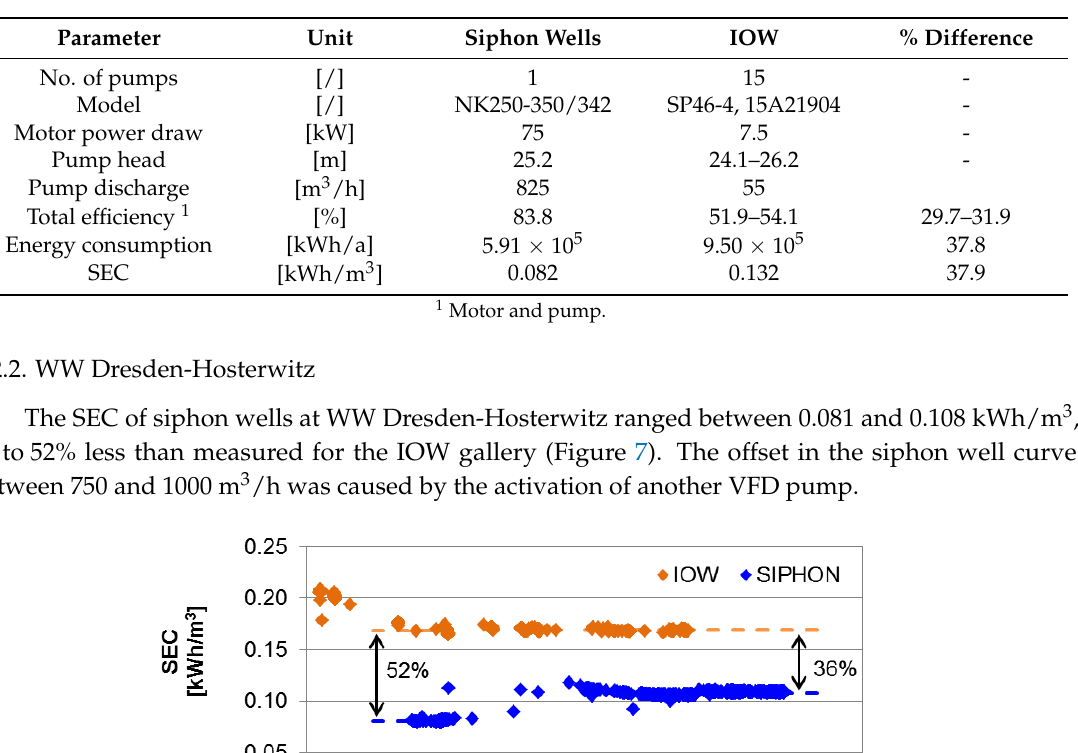
Table 3. SEC of siphon wells versus IOW at the fictional lake bank filtration site.